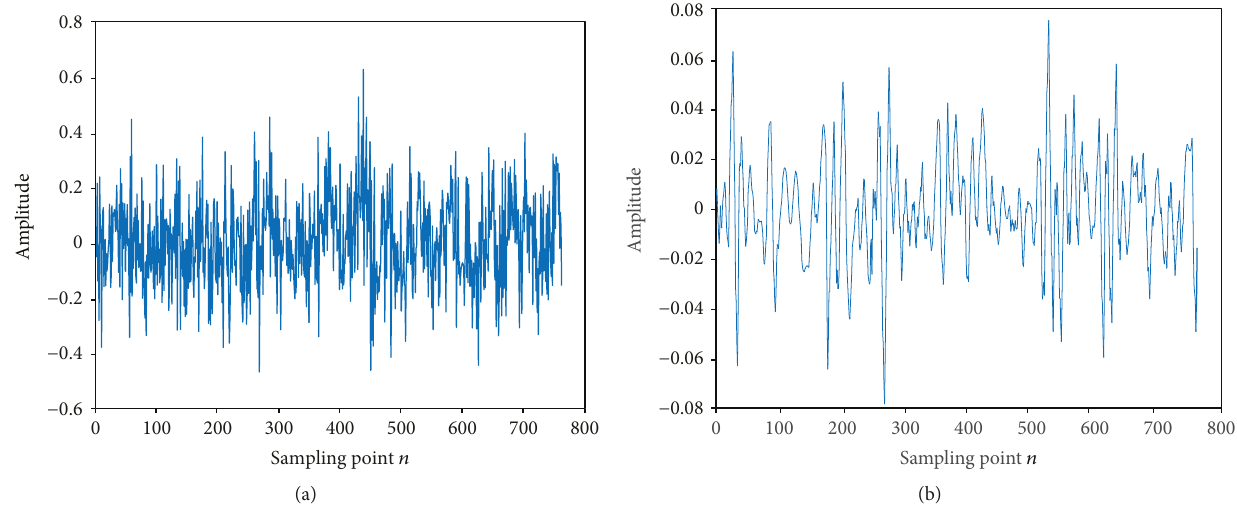
Figure 10: Comparison of prediction error of 17# 1th distance gate sea clutter before and after de-noising. (a) Prediction error before de-noising. (b) Prediction error after de-noising.